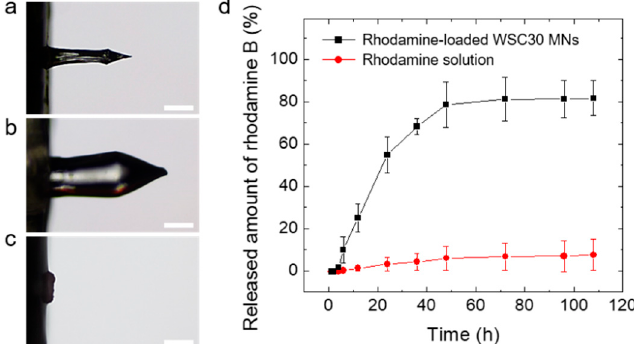
Figure 5. Optical microscope images of the CS MN ( a ) before swelling (dry state), ( b ) after insertion into the hydrogel for 2 min (maximum swollen state), and ( c ) complete dissolution in the hydrogel for 48 h (Scale bar; 250 µ m). ( d ) In vitro permeation profiles of rhodamine B across skin obtained from CS MN patches (5 × 5 MN array) and topically applied rhodamine solutions, respectively. The permeation tests were performed using Franz diffusion cells ( n = 3).